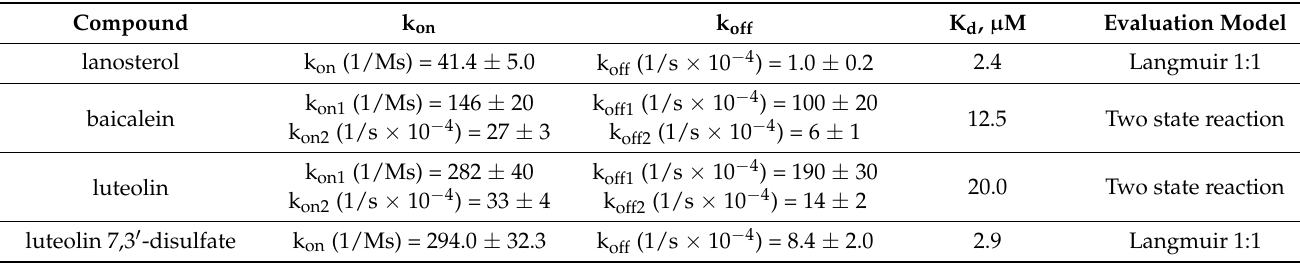
Table 1. Kinetic and equilibrium parameters of cytochrome P450(51) (CYP51A1) complex formation with lanosterol, baicalein, luteolin and luteolin 7,3 (cid:48) -disulfate. Compound Evaluation Model